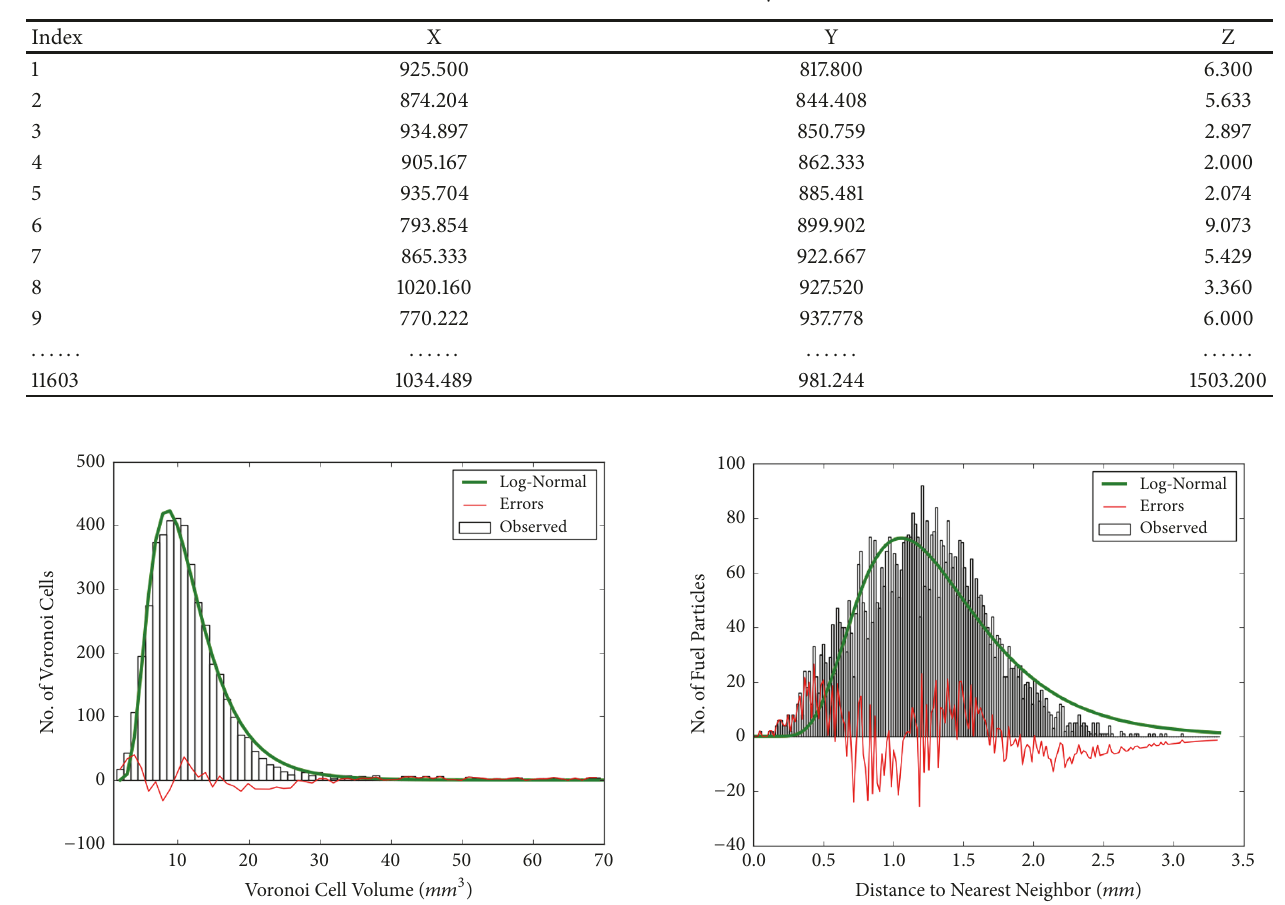
Table 1: Mass center (XYZ) of every TRISO.